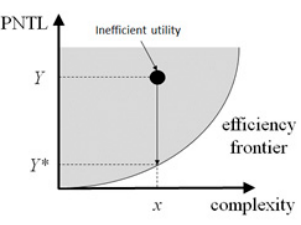
ffi ciency frontier for the Figure 6. Efficiency frontier for the PNTL. Figure 6. E